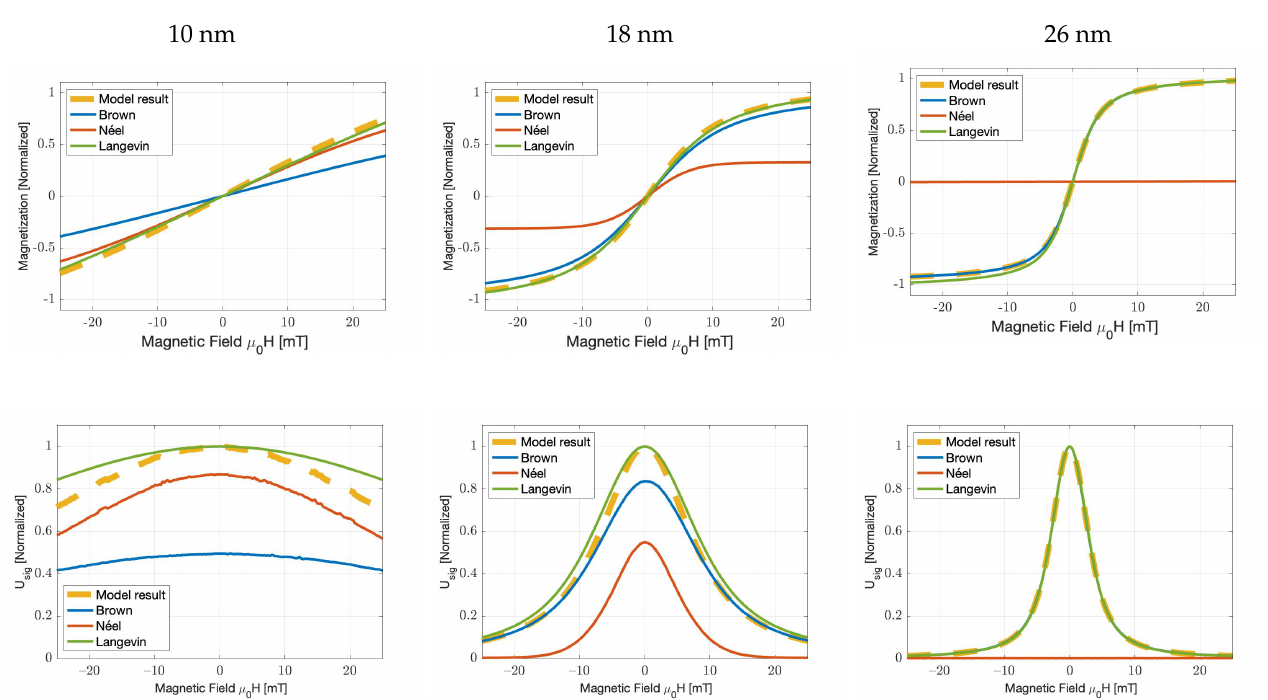
Figure 2. Magnetisation curves, their numerical derivatives and corresponding relaxation times as a function of the magnetic field for monodisperse particles, obtained from the numerical evaluation of the Brownian and Néel FPEs for 10 nm ( left ), 18 nm ( middle ) and 26 nm ( right ) particles. Simulation parameters: K = 20 kJ/m 3 , d h = d c + 12 nm, T = 300 K, α (cid:48) = 0.1, η = 1.0049 mPas, M s = 300 kJ/m 3 T.